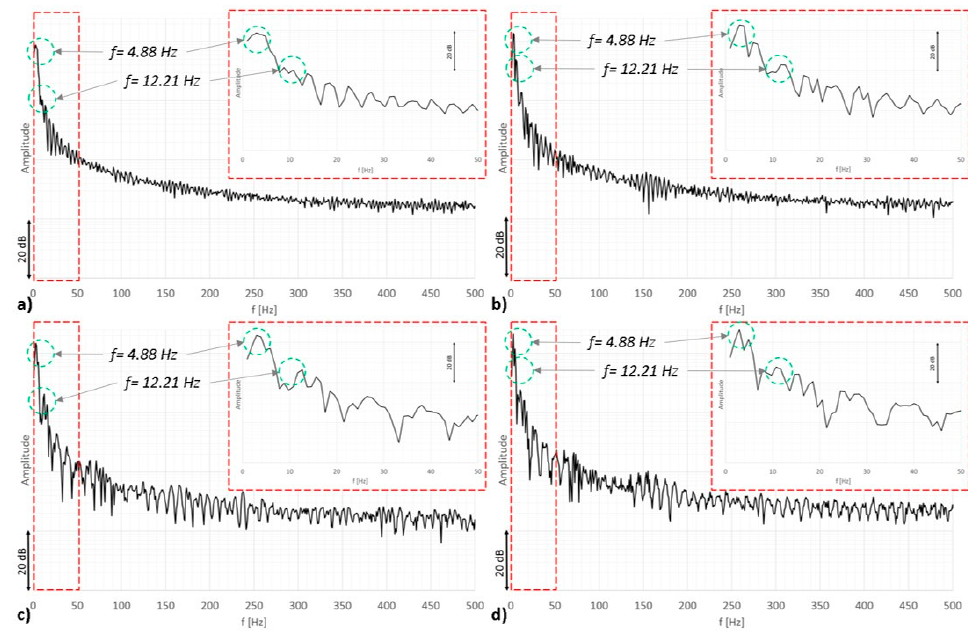
Figure 23. FFT of the FGB signal (F-R2) in the 1024-ms time window encapsulating all the dynamics of the drop test, i.e., the drop phase, first impact, bounce, second impact and subsequent oscillations until damping. The graphs indicated four different heights: ( a ) h = 0.05 m; ( b ) h = 0.10 m; ( c ) h = 0.15 m and ( d ) h = 0.20 m.